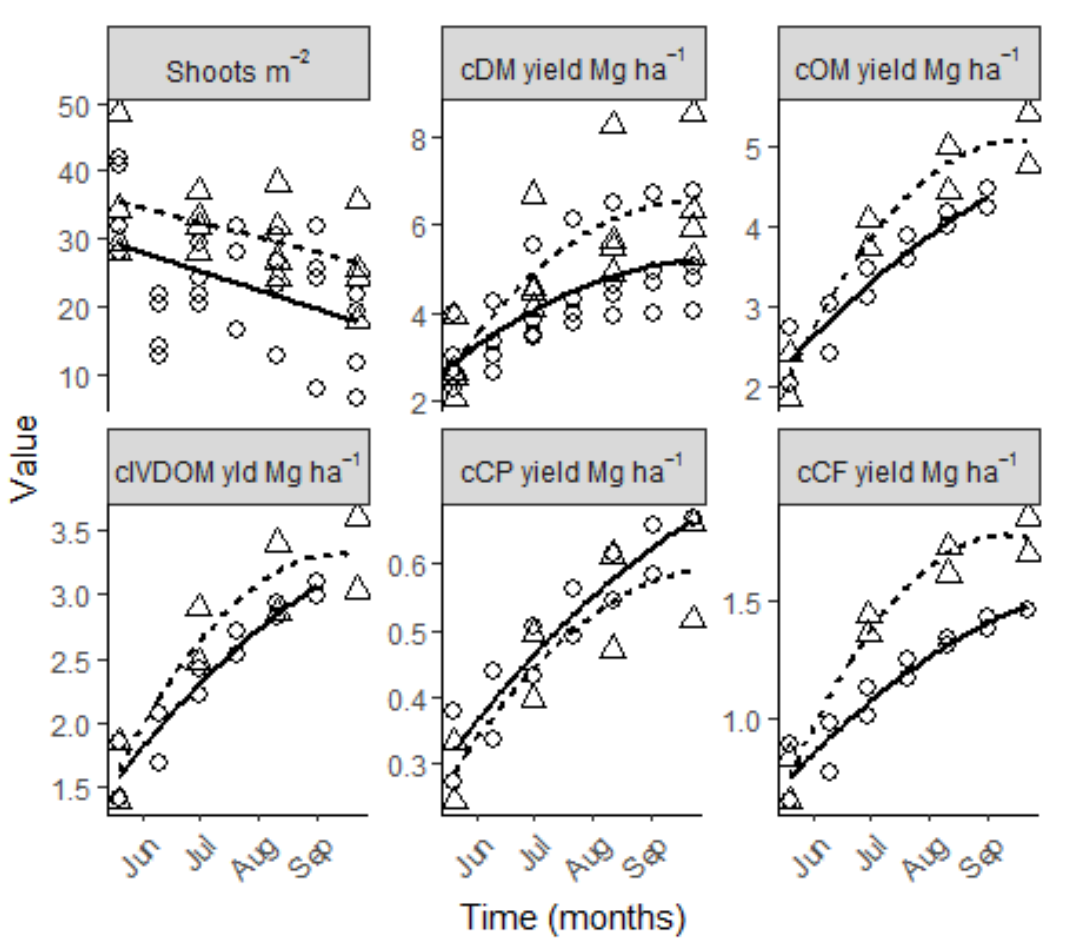
Figure 5. Experiment III: Effect of harvesting frequency (3-week or 6-week intervals) on shoot density and cumulative dry matter (DM), organic matter (OM), in vitro digestible organic matter (IVDOM), crude protein (CP) and crude fibre (CF) yields of T. latifolia biomass contents one year after planting. Harvest dates were 19 May, 02 June, 30 June, 21 July, 11 August, 01 September and 22 September 2017. Fit parameters of the curves are shown in Table